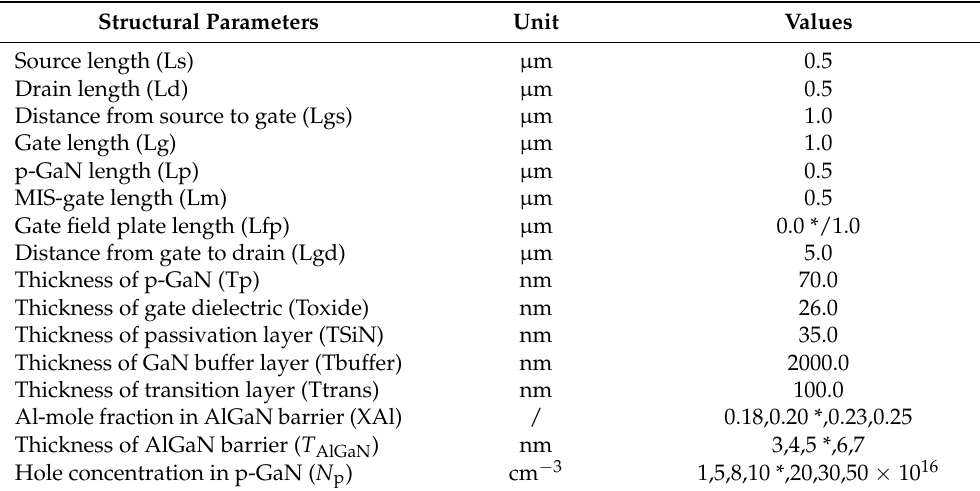
Table 1. Key parameters of the HG-UTB HEMTs used in simulation.